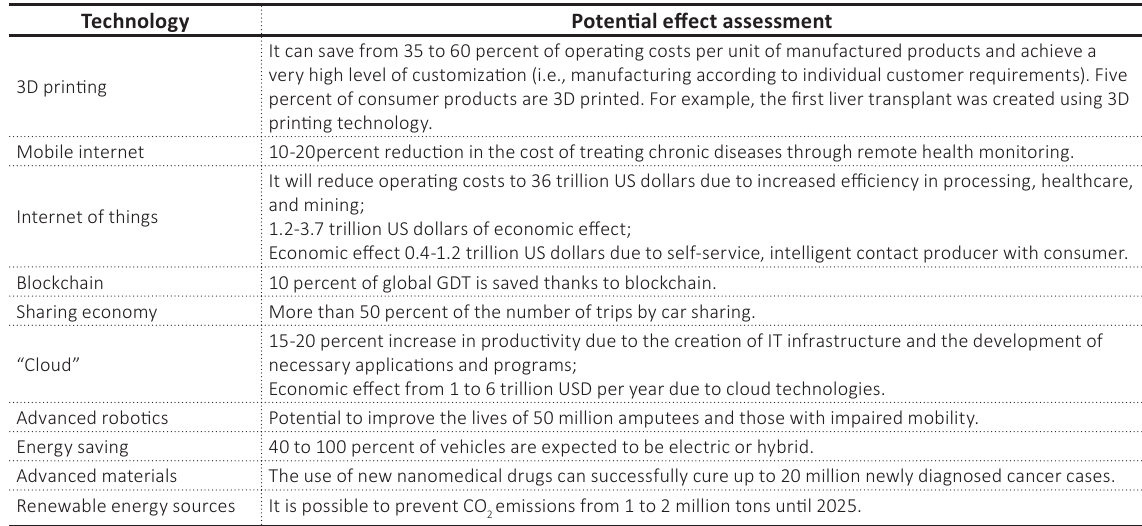
Table 1. Projected effects of additive economy development until